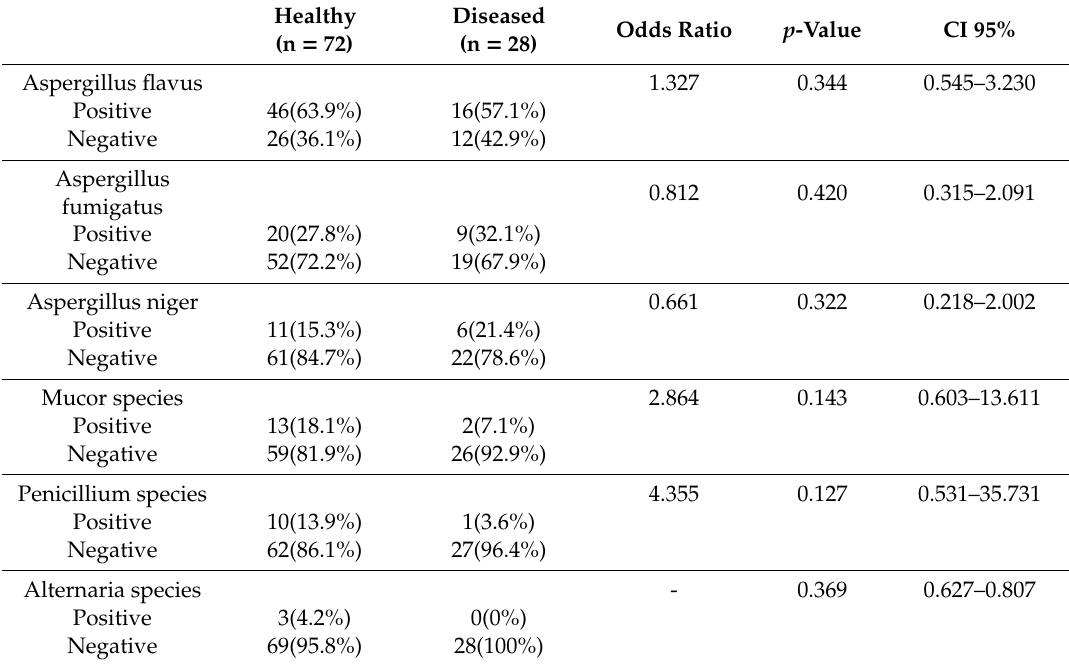
Table 2. The frequency of isolated fungal species between healthy and diseased equine eyes.